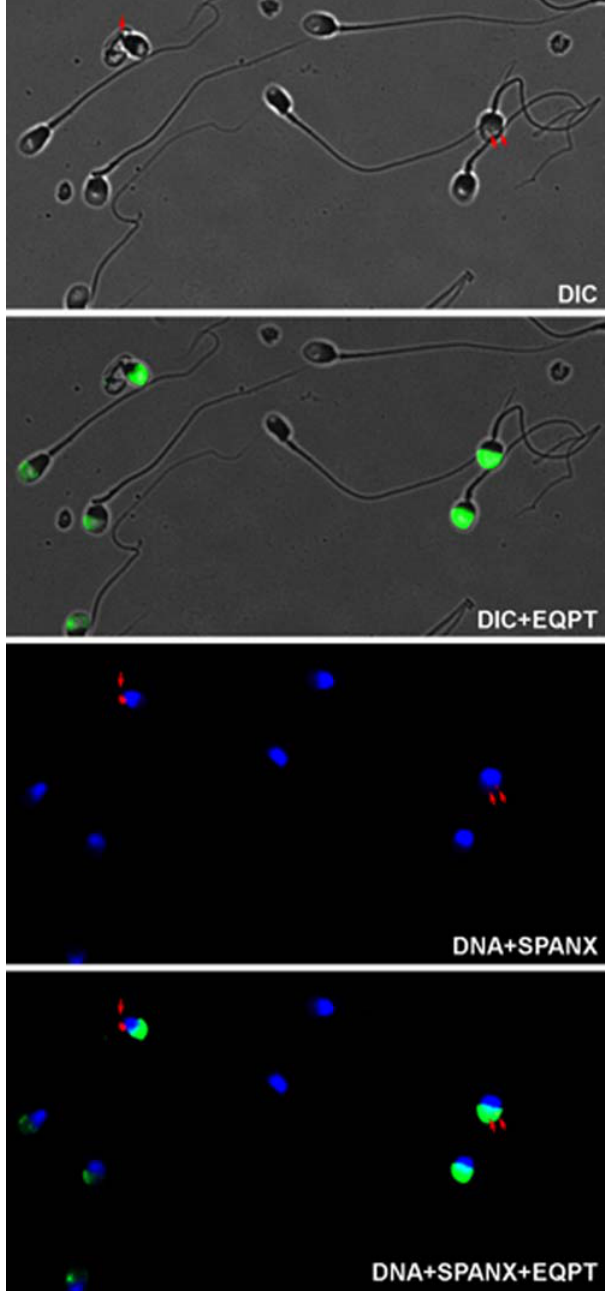
Figure 4. Indirect immunofluorescent staining of fixed, permeabilized swim-up spermatozoa with antibodies against SPANX-N proteins (in green). The SPANX-N immunofluorescence is observed in the acrosome of spermatozoa. The SPANX-A/D immunofluorescence is observed in association with nuclear craters in the cytoplasmic droplet at the posterior sperm head, or in both (red dots). DNA staining with DAPI is in blue.